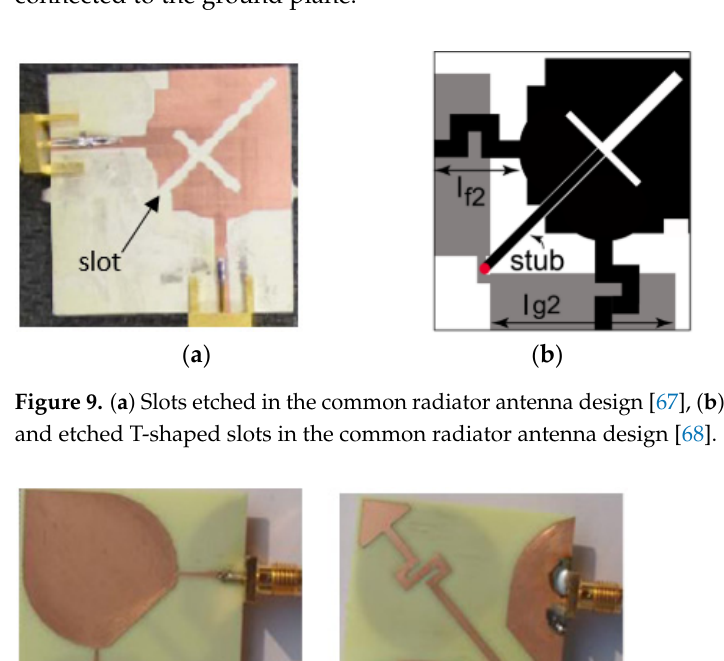
( b ) Figure 8. ( a ) Top layer of ACS-fed structure with common radiator ( b ) Bottom layer [66]. The MIMO antenna design shown in Figure 9b as an ultra-compact size of 22 × 24.3 mm 2 , which is smaller as compared to the designs presented in [65–67]. Figure The design discussed in [68], the single shared radiating element is fed with two perpendicular me- andered microstrip lines. Good isolation is obtained for the entire bandwidth through the placement of an open shunt stub on the radiator and a T-shaped slot in the middle of the radiator. The use of meandered slots reduces the total length while maintaining the elec-